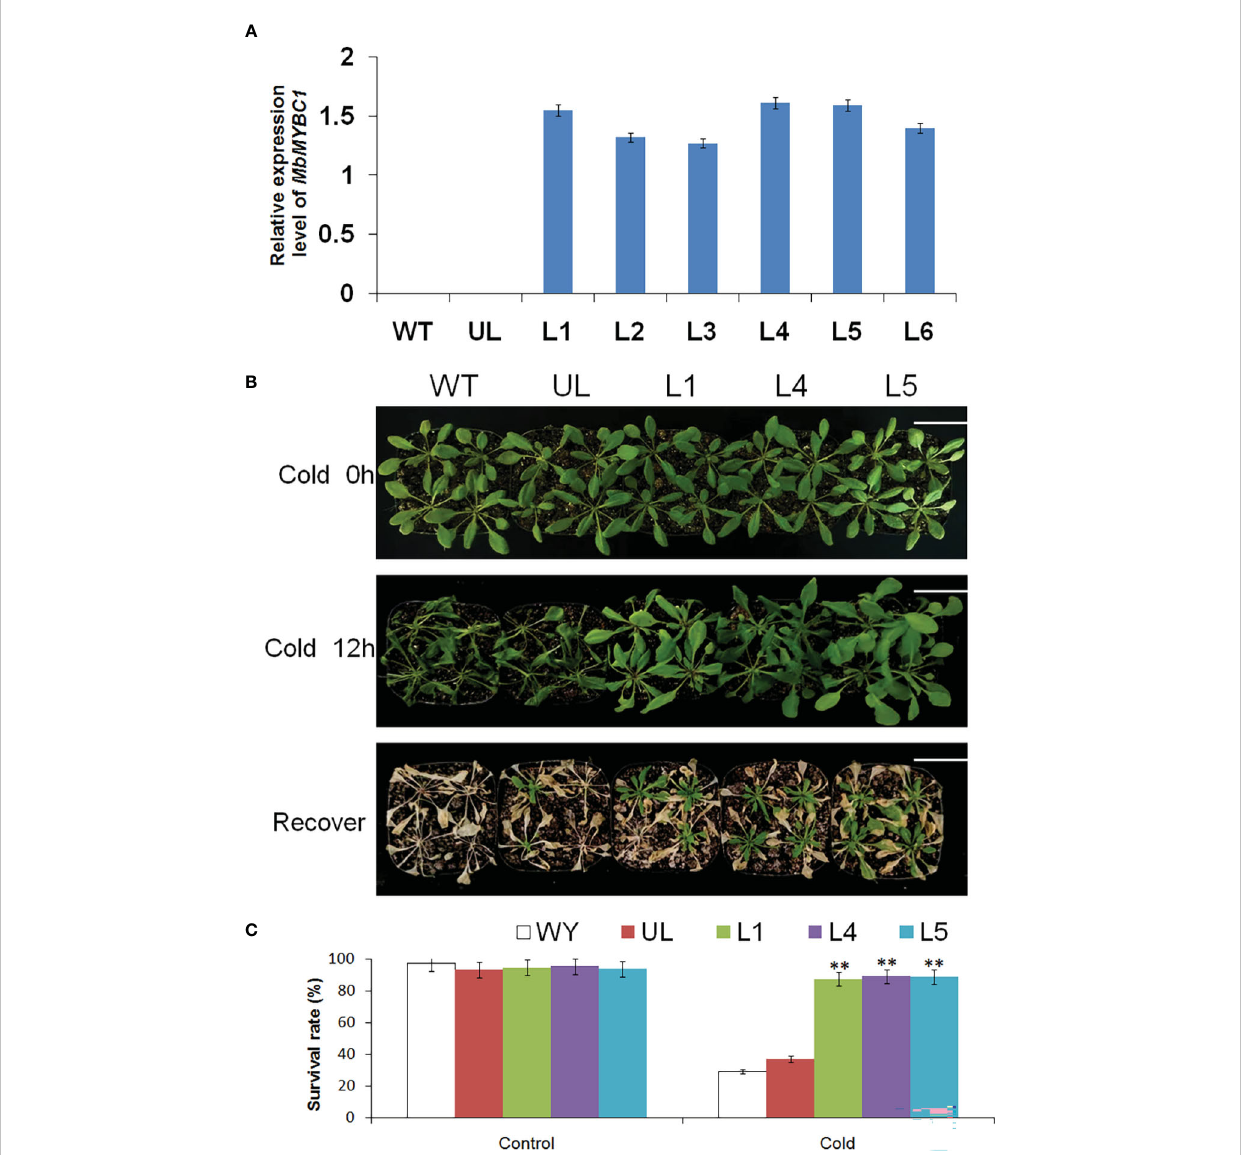
FIGURE 5 Phenotype and survival rate of A. thaliana under low temperature stress. (A) The relative expression of MbMYBC1 in WT, UL and transgenic A. thaliana . (B) The phenotypes of WT, UL, L1/4/5 lines after treatment at -4°C for 0 h, 12 h and recovery growth. (C) The survival rate of A. thaliana under control and low temperature stress. Bar = 5 cm. (**, p ≤